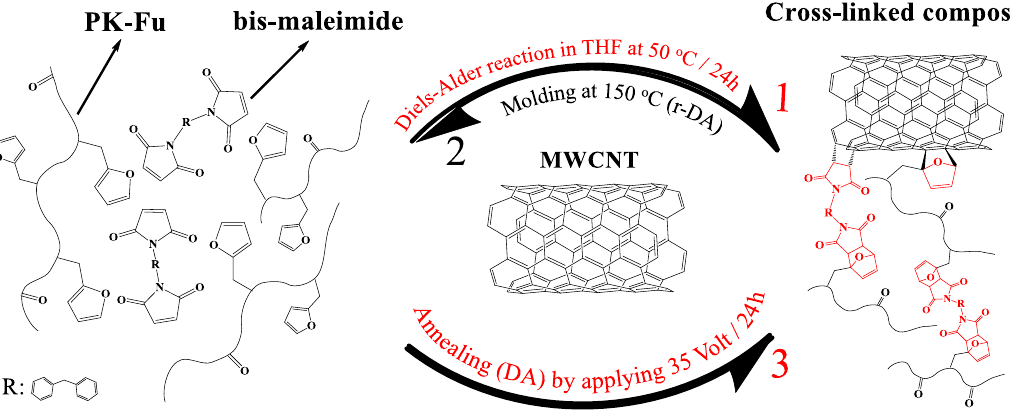
Figure 8. Schematic representation of PK-Fu crosslinked with B-Ma and reinforced with MWCNTs. Arrows display the process of: (1) crosslinking (DA), (2) moulding (partial r-DA) and (3) annealing (DA) by resistive heating.